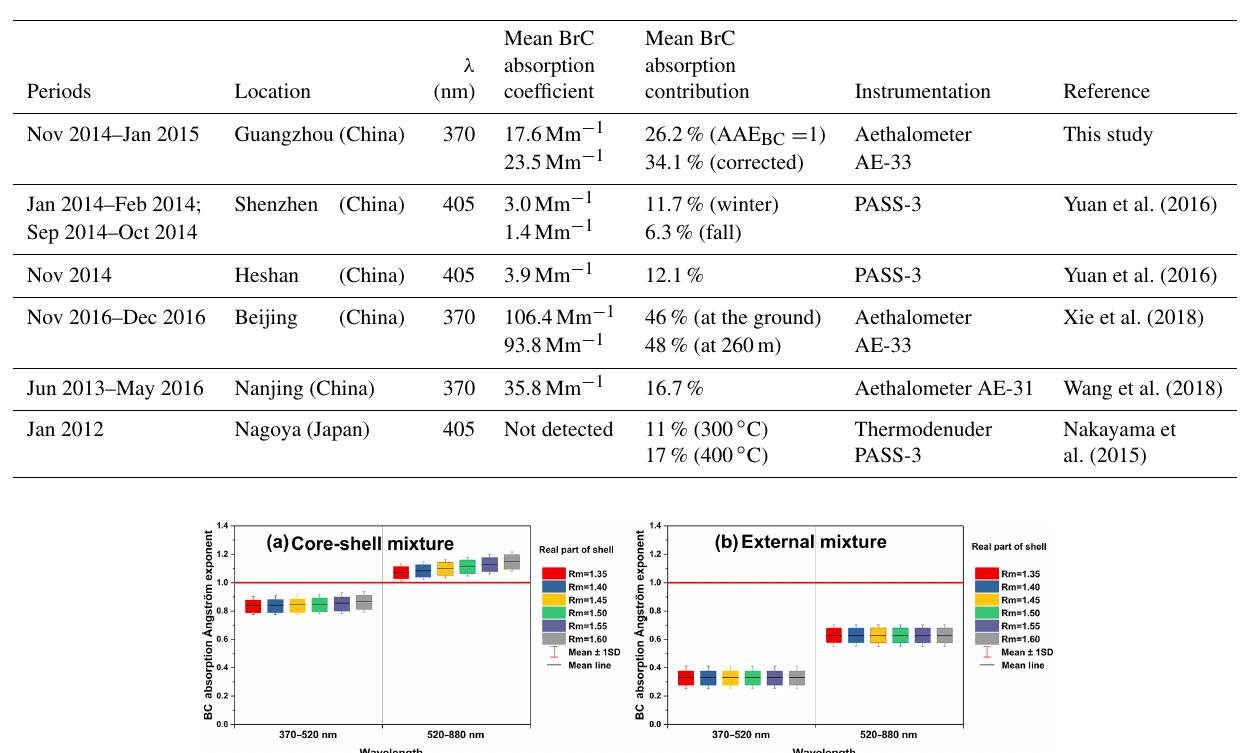
Table 2. Observational studies of the BrC light absorption coefficient and contribution in the near-ultraviolet wavelength range in East Asia.